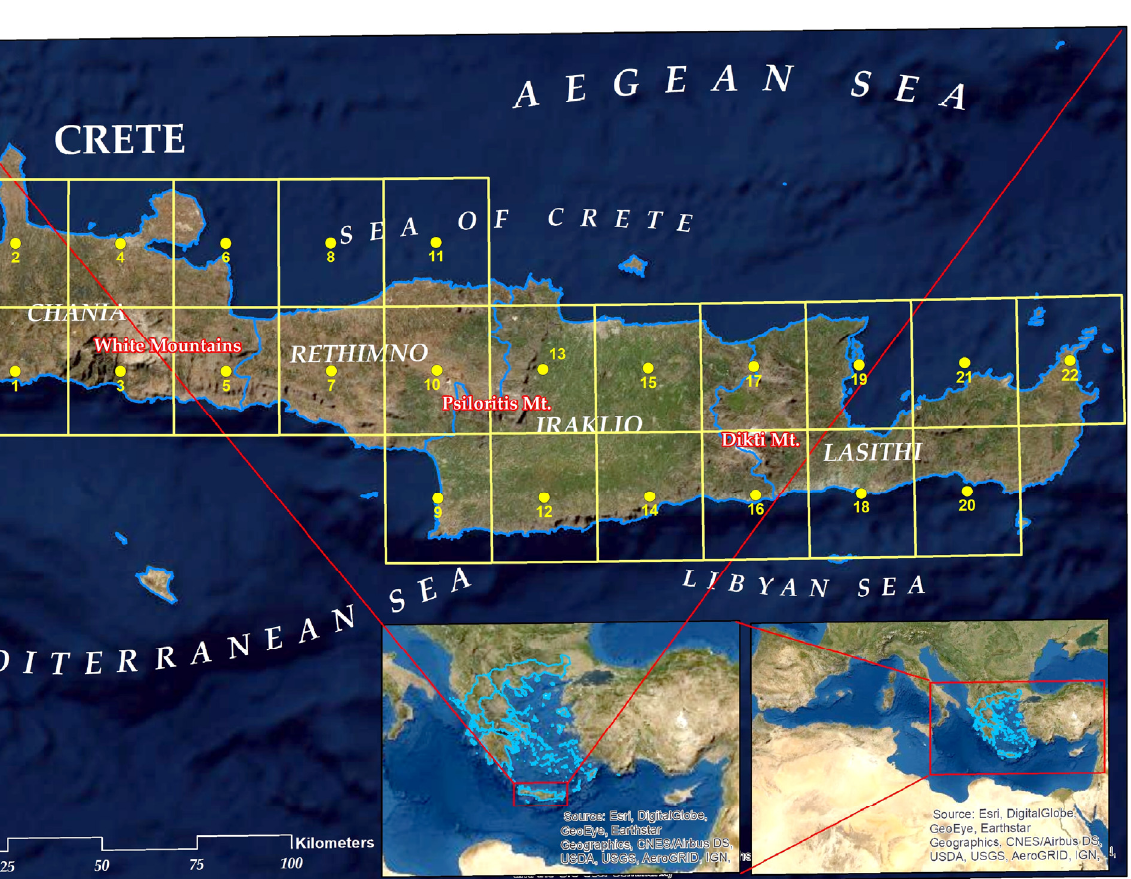
Table 1. Monthly values for Temperature (minimum, maximum and average) Relative Humidity